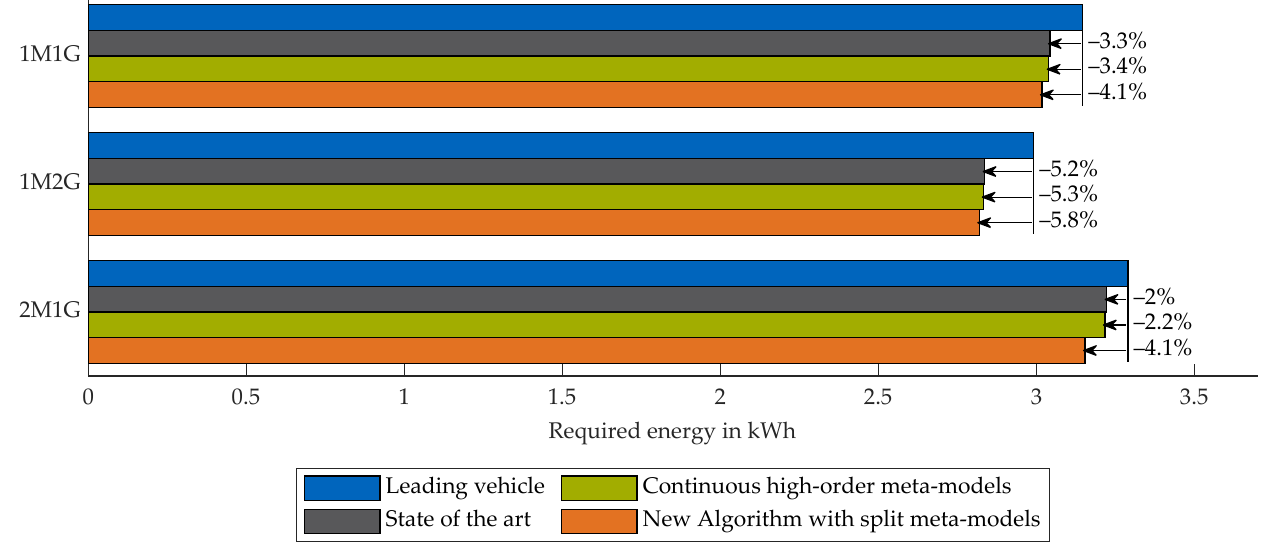
Figure 6. Energy consumption of the leading vehicle and the ego vehicle using different types of eco-driving